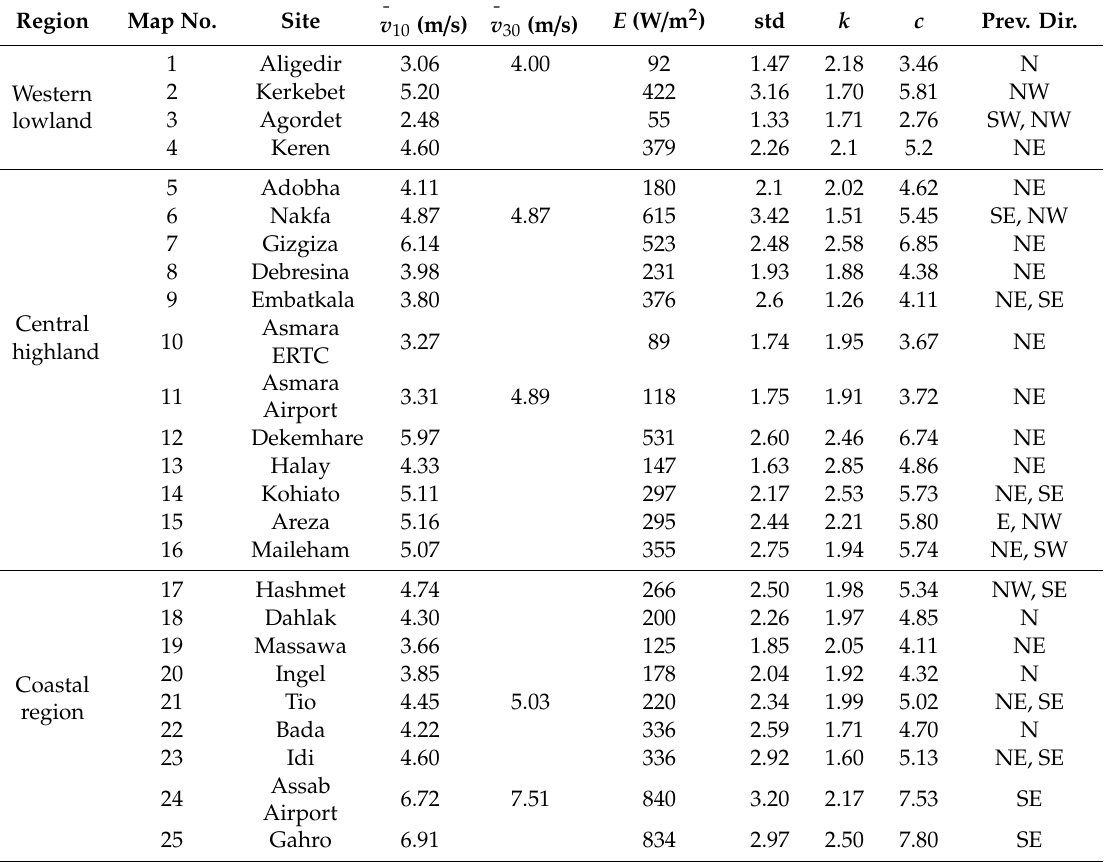
Table 2. Wind speed and characteristics based on measured wind data for the year 2000. Note that v 30 measurements only were available for five sites. All parameters are based on the v 10 values including the wind power density E which is recalculated for 100 m. Map